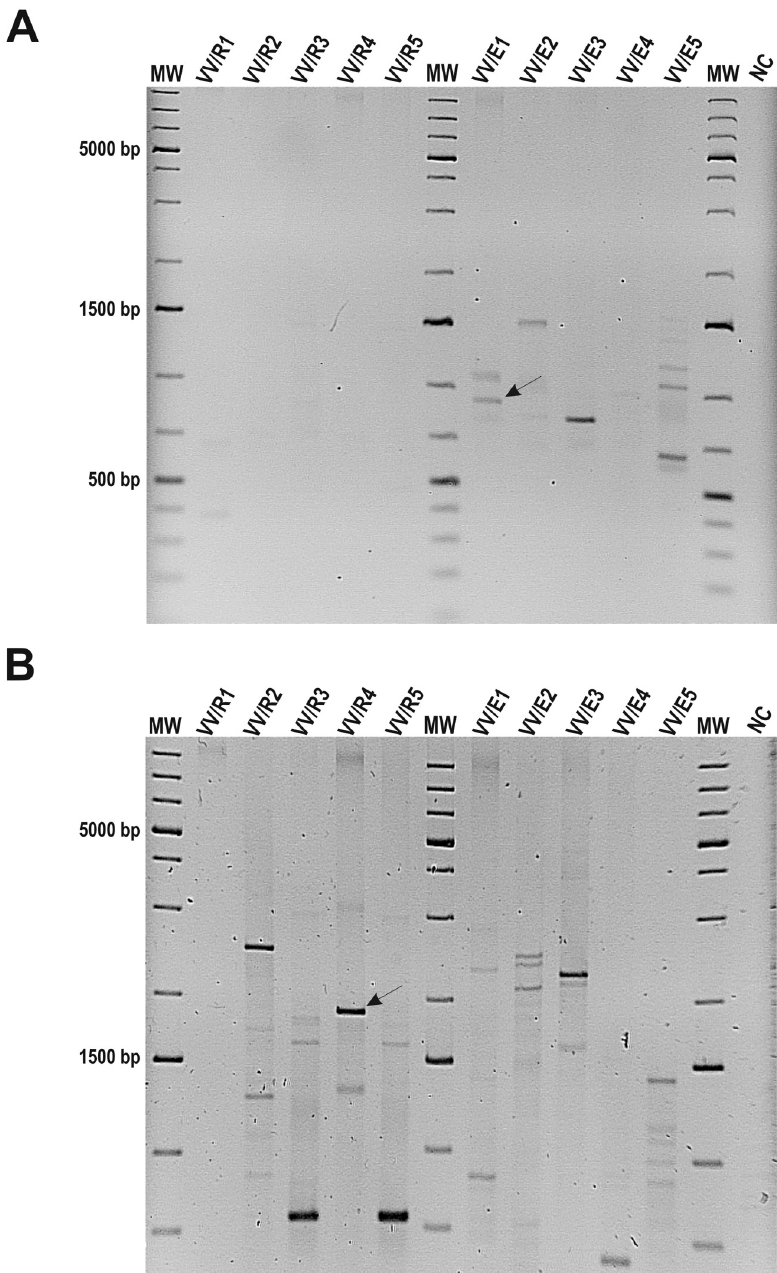
Fig 2. RAPD profiles. RAPD profiles generated by (A) P4 primer and (B) OPA2 primer for rhizosphere (VV/R1 to VV/R5) and endophytic (VV/E1 to VV/E5) Streptomyces sp. strains isolated from the root system of young grapevine plants. MW: GeneRuler 1kb DNA Ladder Plus (Thermo Fisher Scientific). Specific bands amplified from isolates VV/ E1 and VV/R4 that were selected for SCAR markers design are indicated by arrows. NC (negative control). primers, SCAR.E1_fw (positions 415 to 439; Fig 3A) and SCAR.E1_rv (positions 576 to 596; Fig 3A), were selected for Streptomyces sp. VV/E1 strain. Both primers were in the intergenic region located between the two ORFs detected. The SCAR.E1_fw and SCAR.E1_rv primers were designed with a 48.0% and 52.4% GC content, respectively, and they amplified a unique